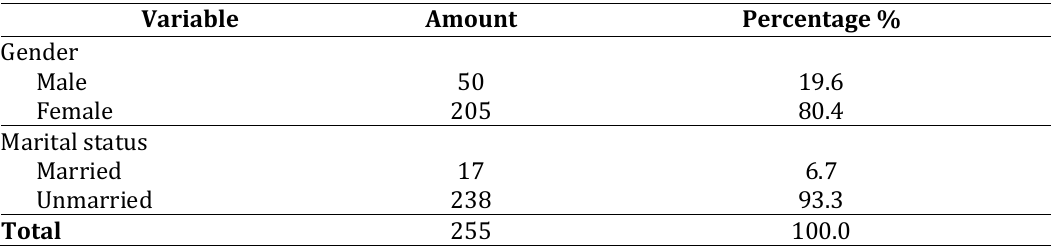
Participant’s Characteristic Distribution Based on the Gender and Marital Status